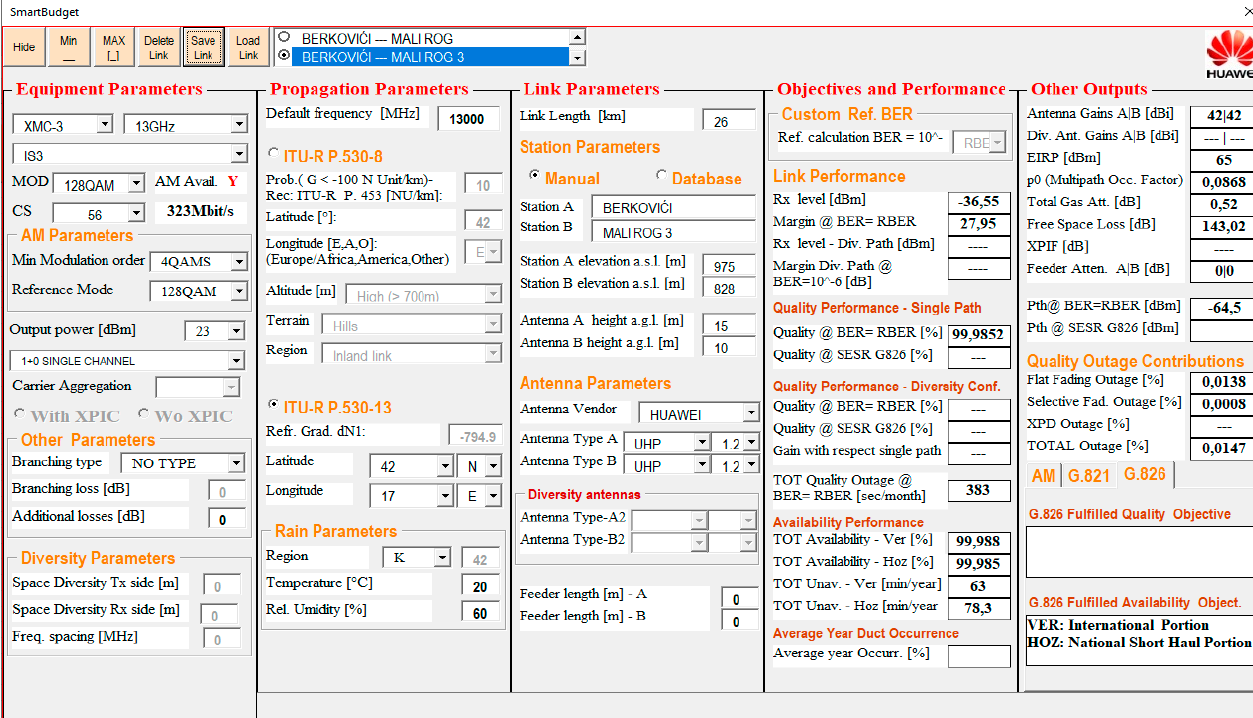
Figure 13. Prediction for the third RR section; 128 QAM, 323 Mb/s.